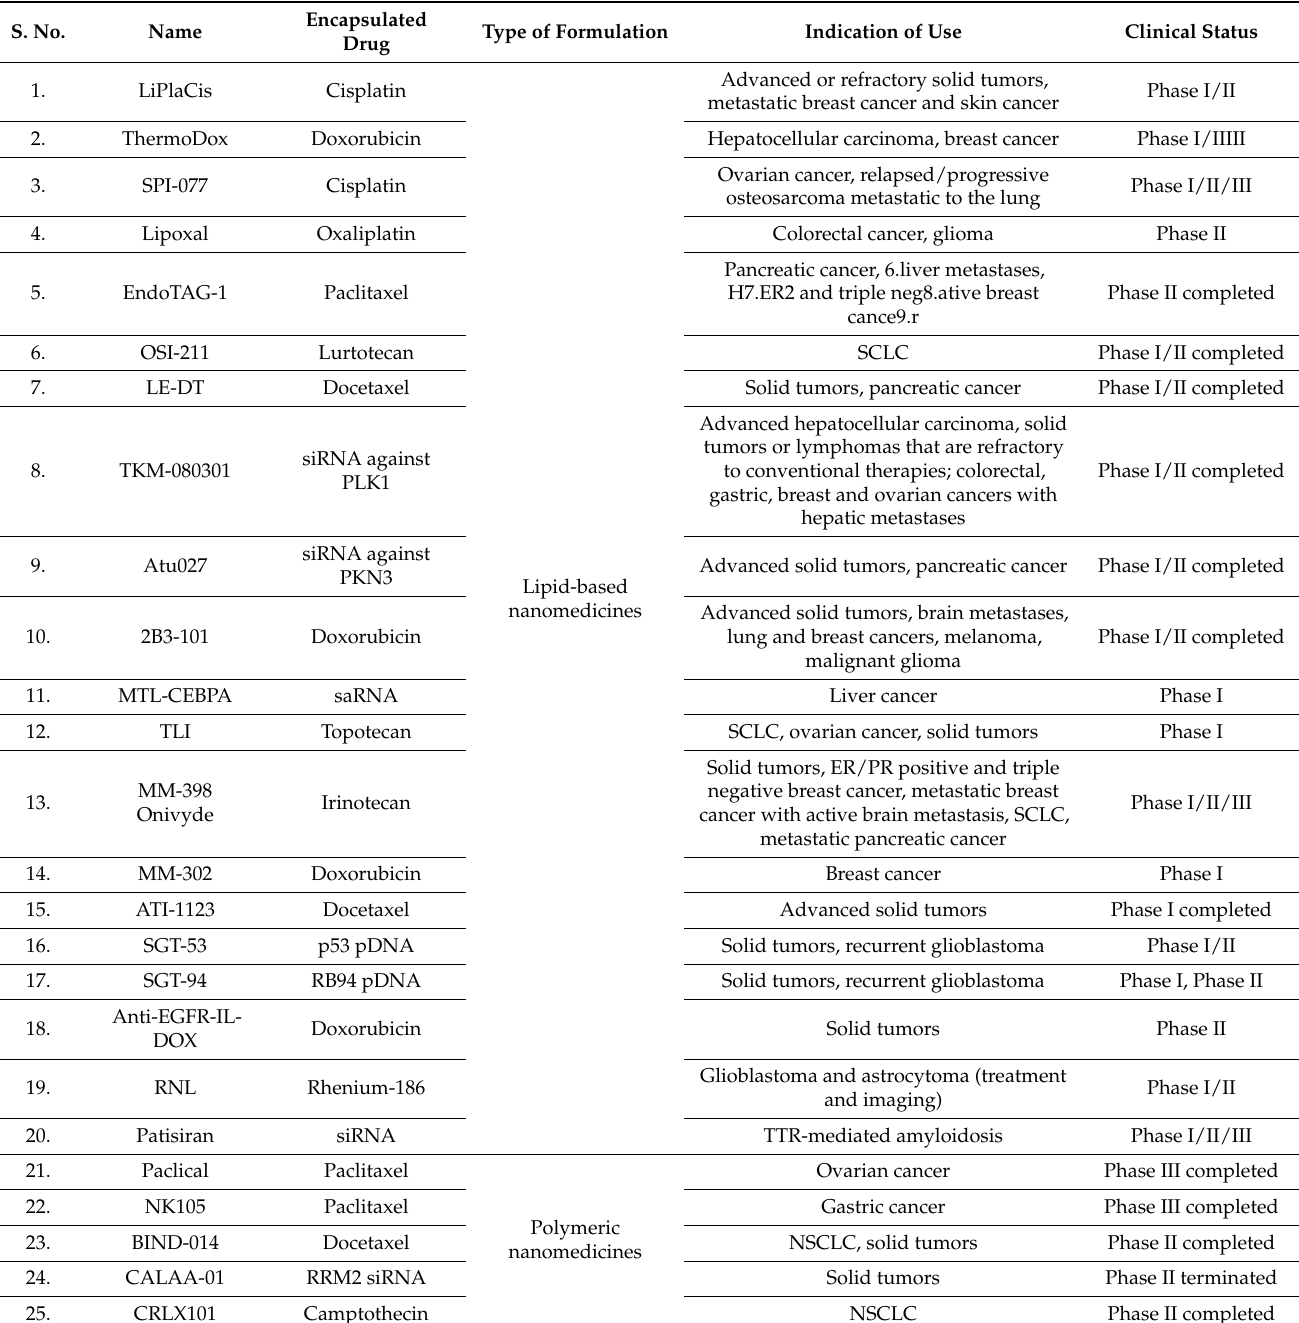
Table 4. Current clinical stages of various nanoformulations and nanomedicines (reprinted with permission from